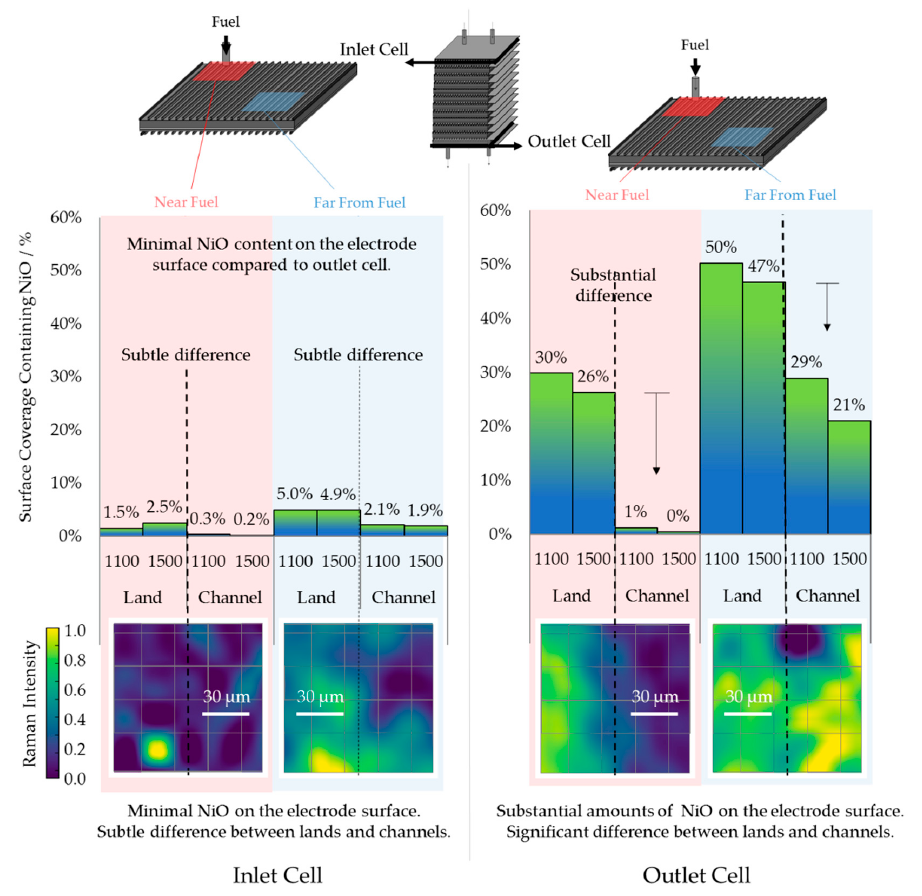
Figure 3. Raman spectroscopy mapping of the anode surface at various locations within an SOFC stack. Surface coverage was calculated for both 1100 and 1500 cm − 1 Raman peaks. Raman maps are reported from the 1100 cm − 1 peak. Gridlines indicate approximate spatial